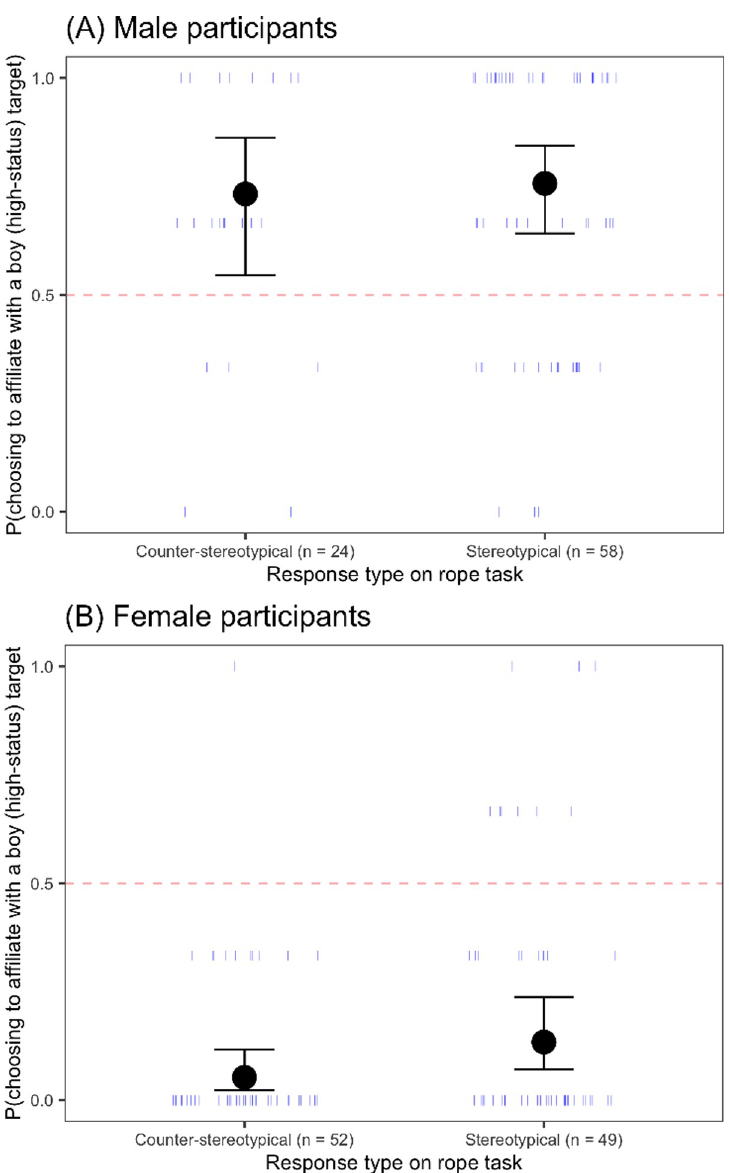
Fig 4. Probability of choosing to affiliate with a boy (high-status) target as a function of response type on the rope task and participant gender for (A) male participants and (B) female participants. Circles represent the means for each group, and error bars represent 95% confidence intervals around the means; dashes represent individual